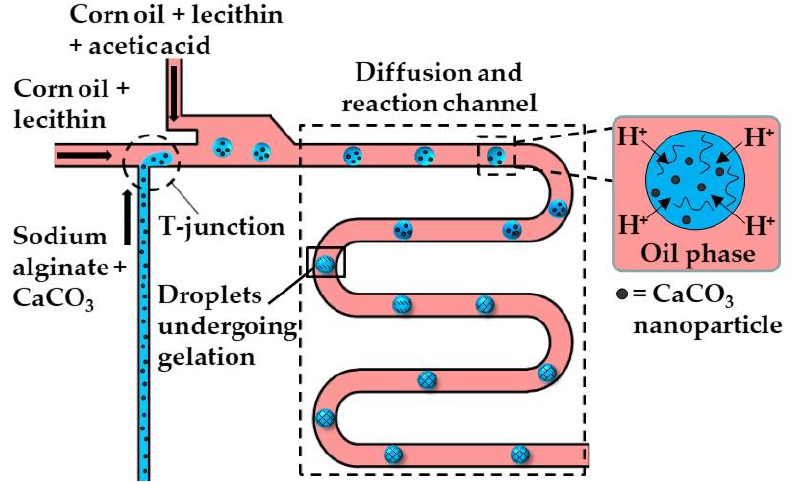
Figure 2. The formation of alginate beads by internal gelation. Droplets of sodium alginate solution loaded with CaCO 3 are formed at the upstream T-junction. The resulting emulsion is mixed with acid-saturated oil delivered through the side channel, and is forced to pass through the wavy channel to allow enough time for acetic acid to diffuse to the droplets and trigger Ca 2+ release [31].